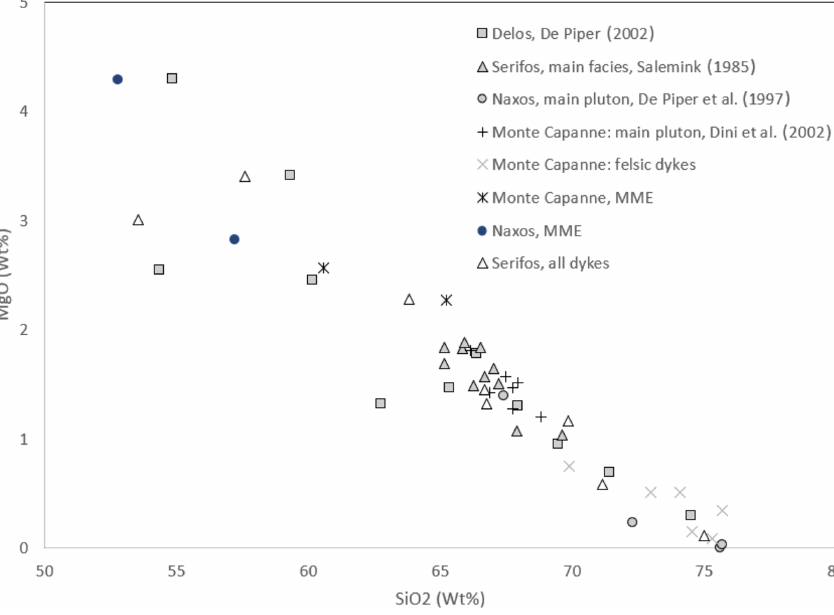
Solid Earth, 12, 1357–1388,